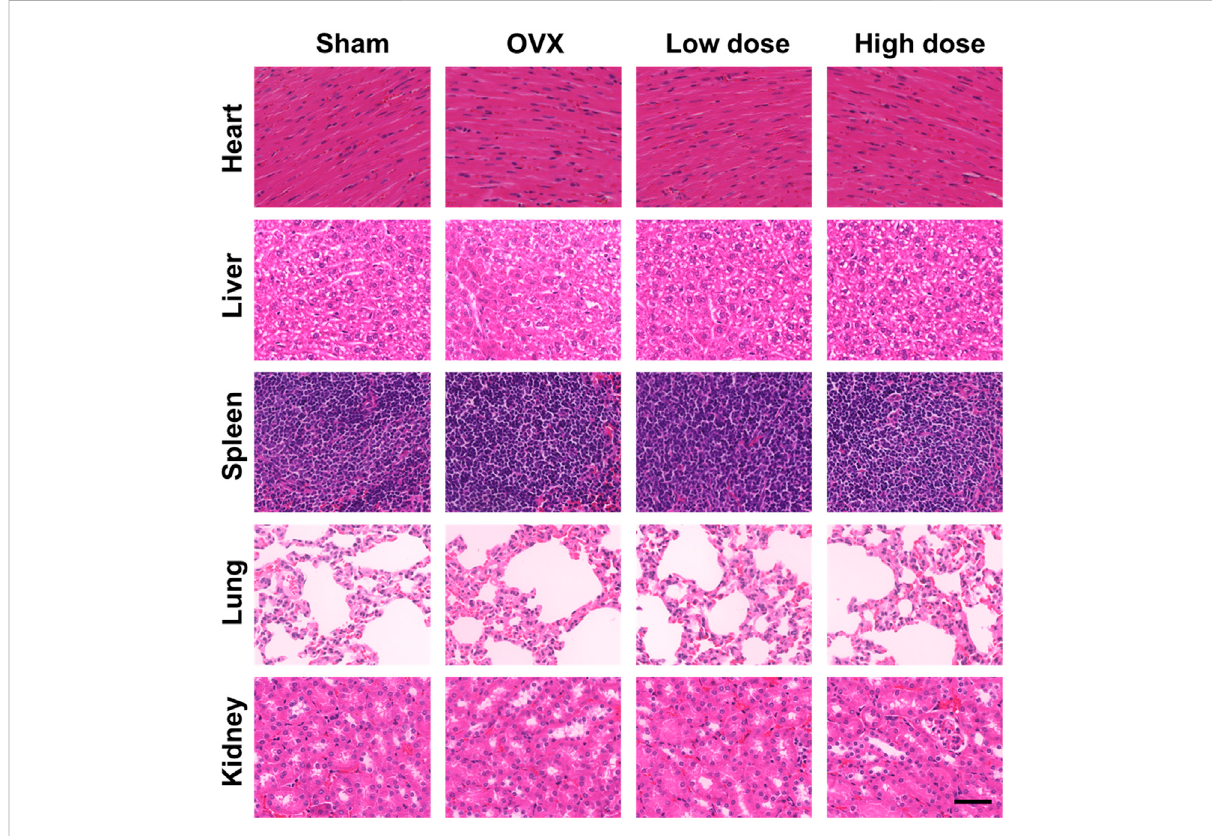
FIGURE 8 In vivo toxicity evaluation. No histologic evidence of organ toxicity was detected at the applied doses in the H&E staining of the heart, liver, spleen, lung and kidney tissues of mice from each group (scale bar = 50 μ